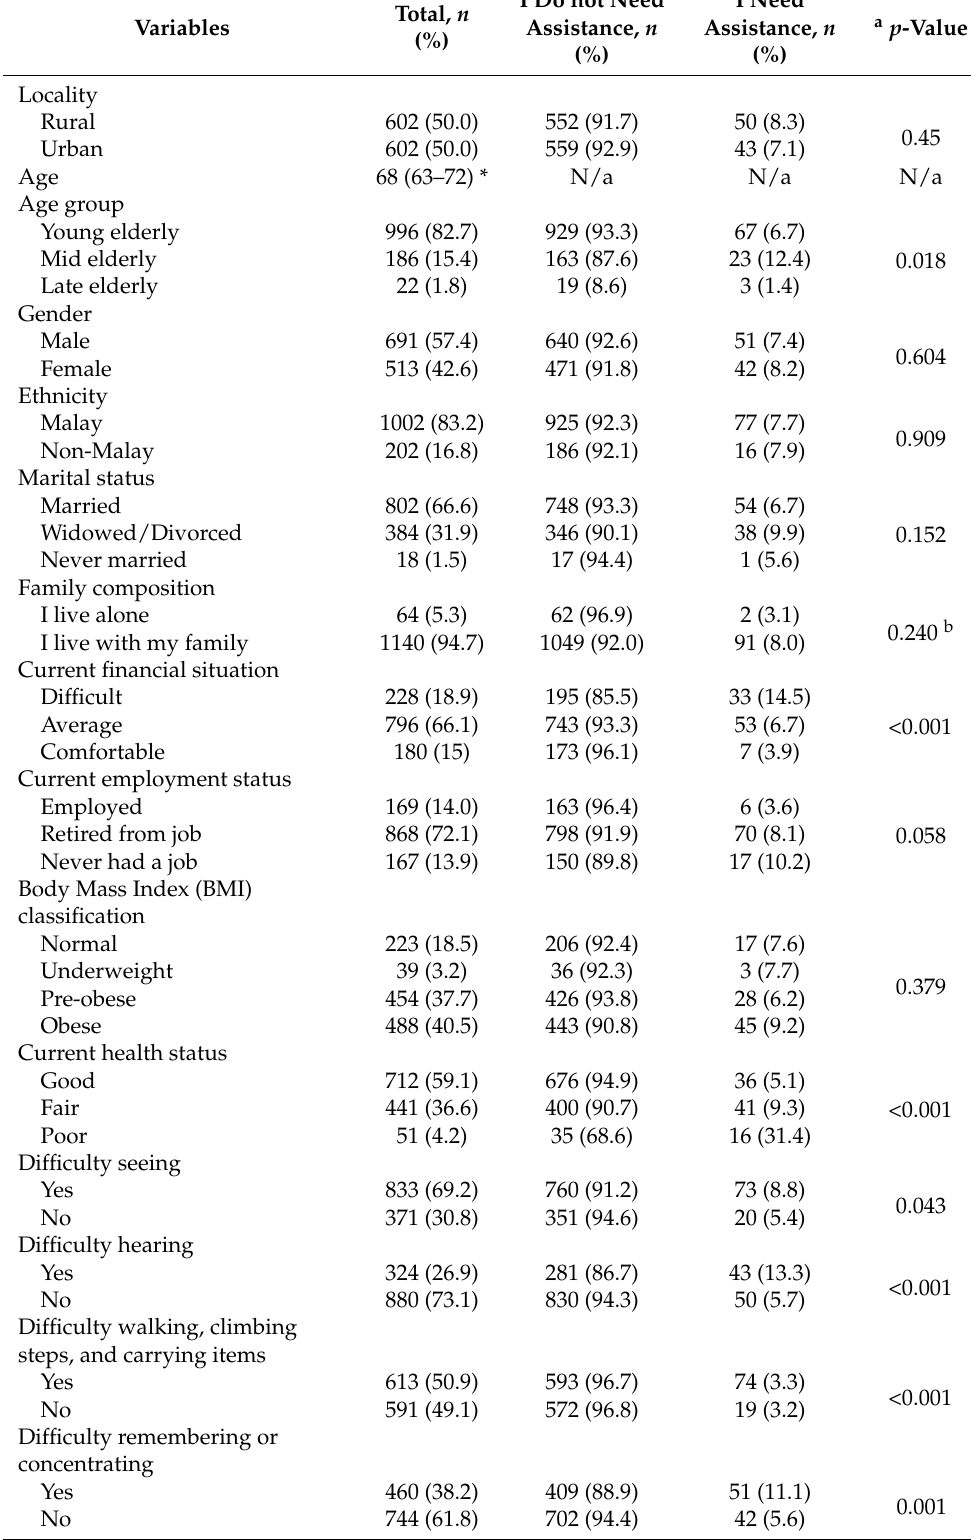
Table 1. Descriptive and bivariate analysis of factors associated with the need for